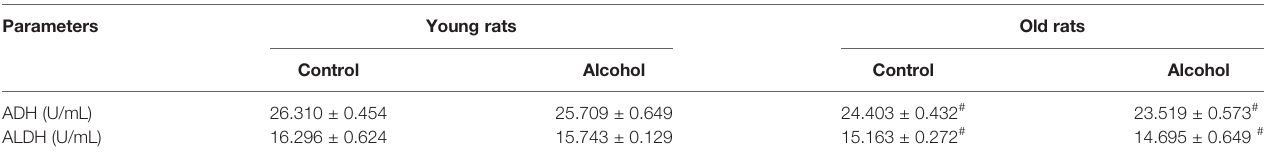
TABLE 1 | Alcohol metabolism in young and old rats. Parameters Young rats Old